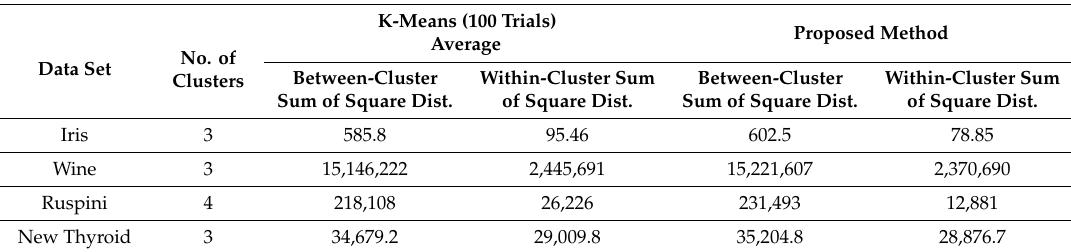
Table 2. Comparison of K-means algorithms with di ff erent datasets. Dist = distance.